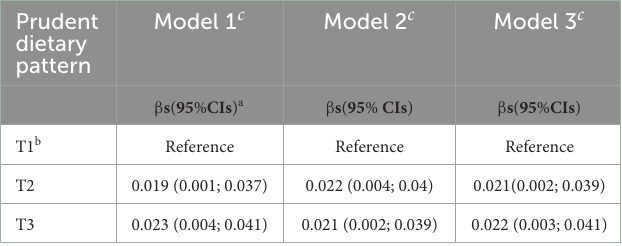
TABLE 3 Univariate comparison of the age at menarche according to anthropometric characteristics, dietary patterns, and maternal characteristics of 215 girls from the Growth and Obesity Chilean Cohort Study.